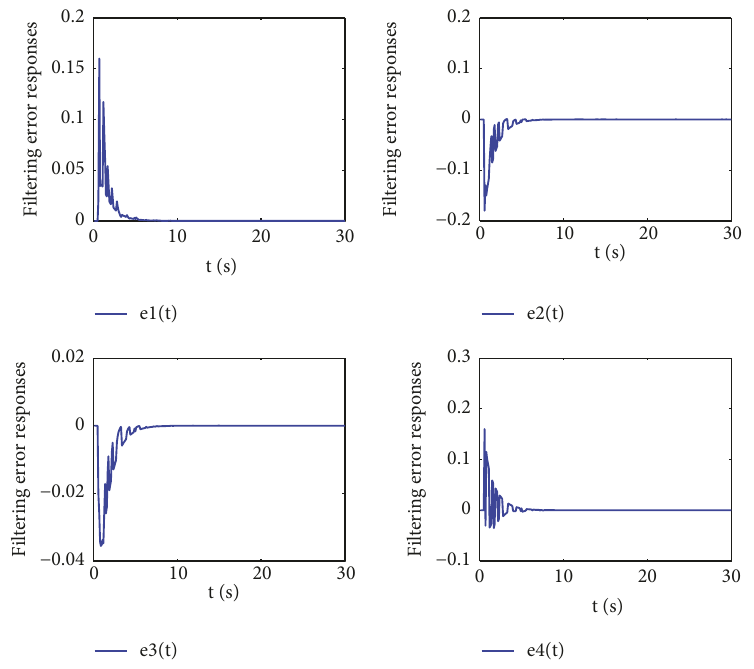
Figure 3: Filtering error